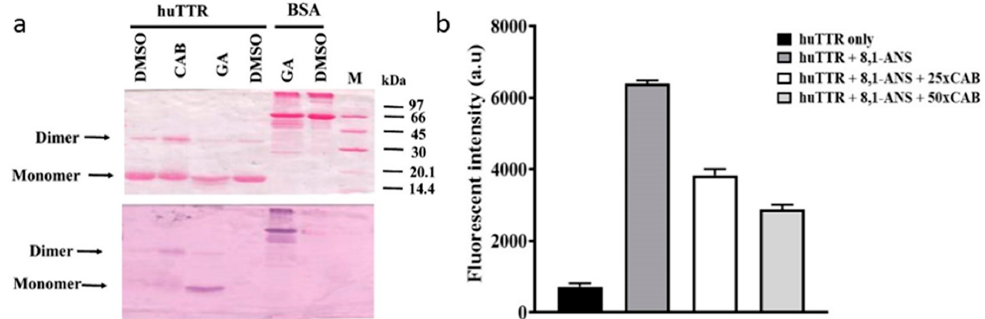
Figure 1. ( a ) Ponceau S staining of human transthyretin (huTTR) treated or non-treated (vehicle) with bioactives after electroblotting of SDS-PAGE onto the nitrocellulose membrane (above). Protein: Drug ratio of 1:10. Nitroblue tetrazolium (NBT)/glycinate staining of the membrane above after de-staining Ponceau S (below). ( b ) Displacement of bound 8-anilino-1-naphthalene sulfonic acid from huTTR by increasing concentrations of Centella asiatica (CAB). The bar chart columns and error bars represent the means of triplicates and standard deviations,